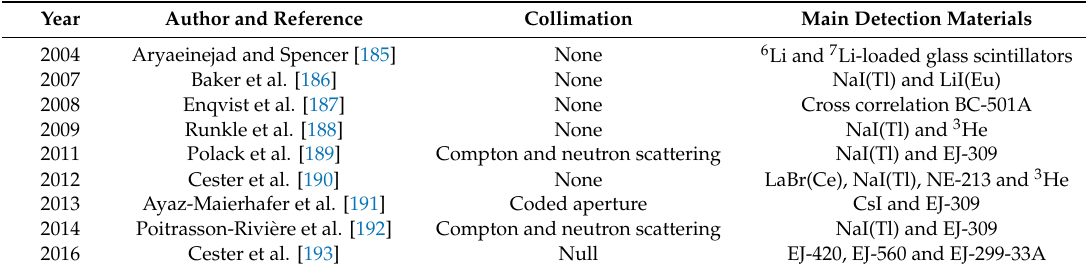
Timeline of dual particle multiple detectors imaging system in security and non-proliferation